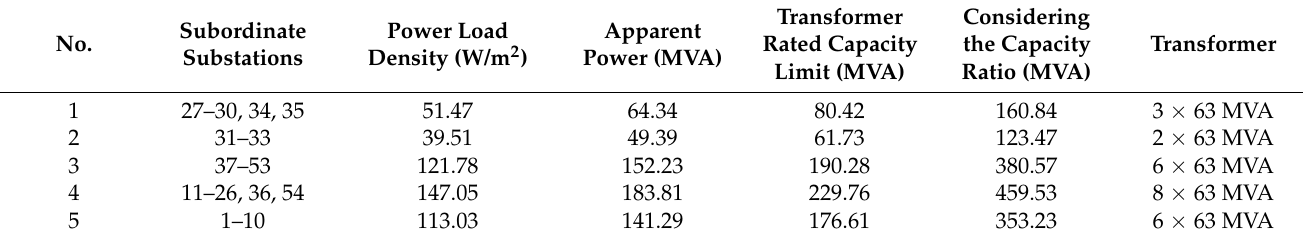
Table 15. Determination of 110 kV